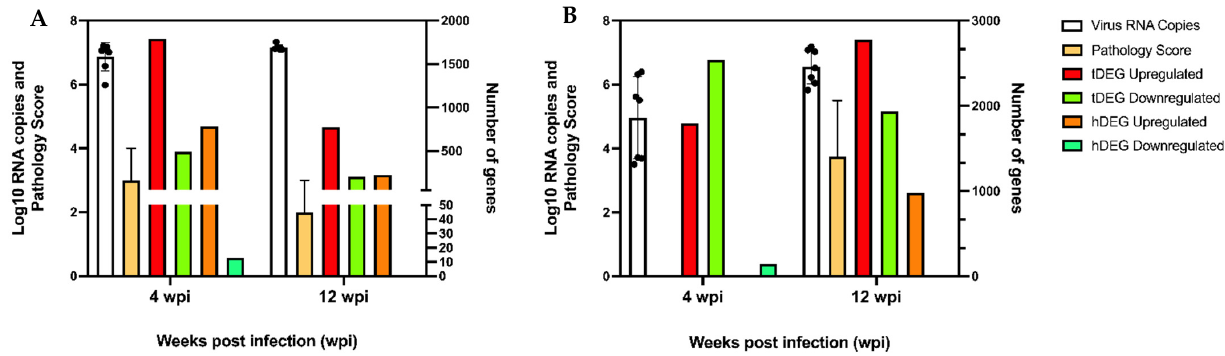
Figure 2. Overview of viral RNA copies and pathology scores in the brains of ducks and chickens alongside total and highly differentially expressed genes in those tissues. In ( A ), data are presented for Muscovy ducks at 4 wpi and 12 wpi. In ( B ), data are presented for chickens at 4 wpi and 12 wpi. The left y -axis shows both the log 10 RNA copies and pathology scores. The right y -axis shows the number of differentially expressed genes. The x -axis shows the weeks post-infection. tDEG stands for total differentially expressed genes and hDEG stands for highly differentially expressed genes. The viral-RNA and pathology-score data used in this figure are adapted from [15,16]. Table 2. Total (tDEG) and highly (hDEG) differentially expressed genes in the brains of ABBV-1- infected Muscovy ducks and chickens.